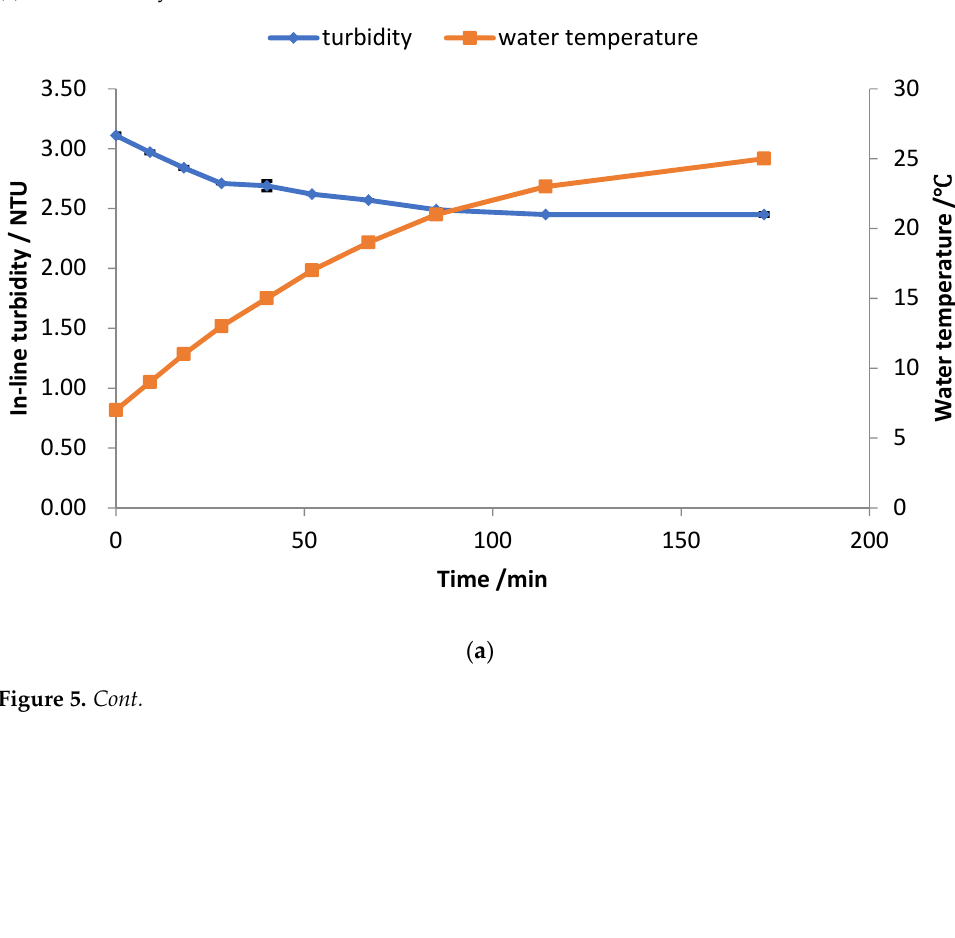
Figure 4. Scatterplot graphs for the in-line turbidity and water temperature original data set after the cooling water treatment. ( a ) Water velocity is set as 0.33 m/s. ( b ) Water velocity is set as 0.66 m/s. ( c ) Water velocity is set as 1.66 m/s.